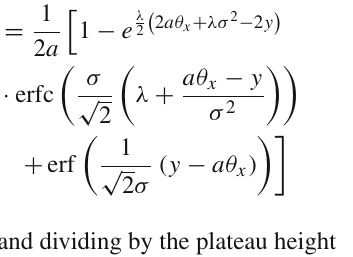
Fig. 5 The Gaussian example with μ = 0 . 2 y and σ = 0 . 07 y + 2 · 10 − 5 y 2 . No constant plateau arises, hence the method is not applicable and b does not represent the trigger efficiency